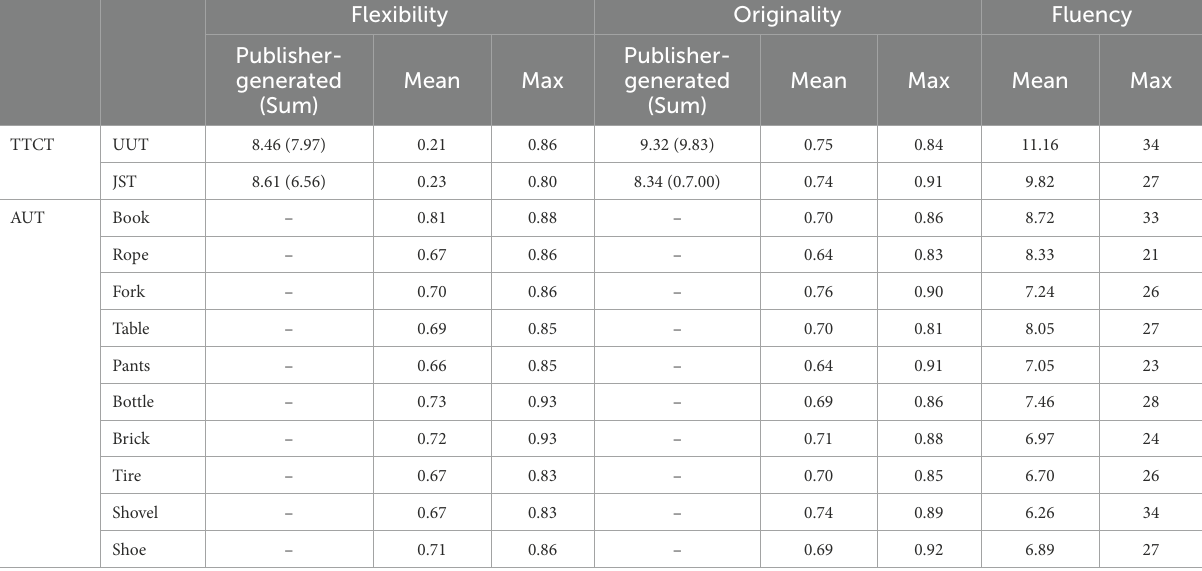
TABLE 2 Item level descriptive statistics for studies 1 and 2.